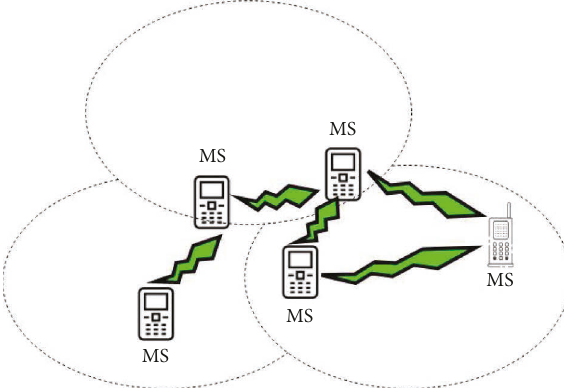
Figure 7: Ad hoc model.